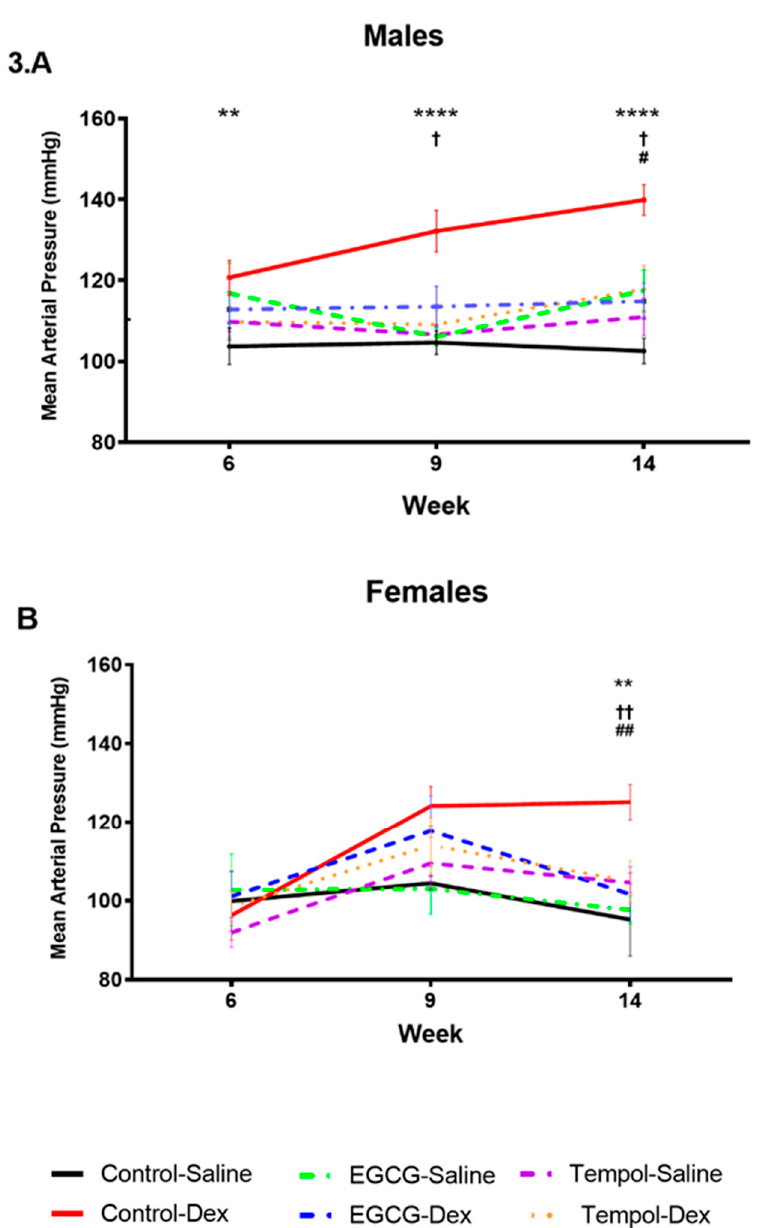
Figure 3. The impact of in-utero antioxidant administration on mean arterial pressure in Dex programmed offspring. Mean arterial pressure of Dex-exposed animals administered EGCG or TEMPOL in-utero throughout gestation in males ( A ) and females ( B ). Measured using the CODA 8 blood pressure monitor from Kent Scientific. Saline and Dex control have been published previously and have been provided for reference [7]. Two-way ANOVA (Fisher’s LSD test): significance is shown as †/# p ≤ 0.1, **/††/## p ≤ 0.05, **** p ≤ 0.0001. The symbols (*/†/#) represent statistical significance; (*) between Control-Saline and Control-Dex, (†) between Control-Dex and Tempol-Dex and (#) between Control-Dex and epigallocatechin gallate (EGCG)-Dex. n = 6 per group. Significant interactions between maternal injection and antioxidant administration were found at week 14 for males and females.